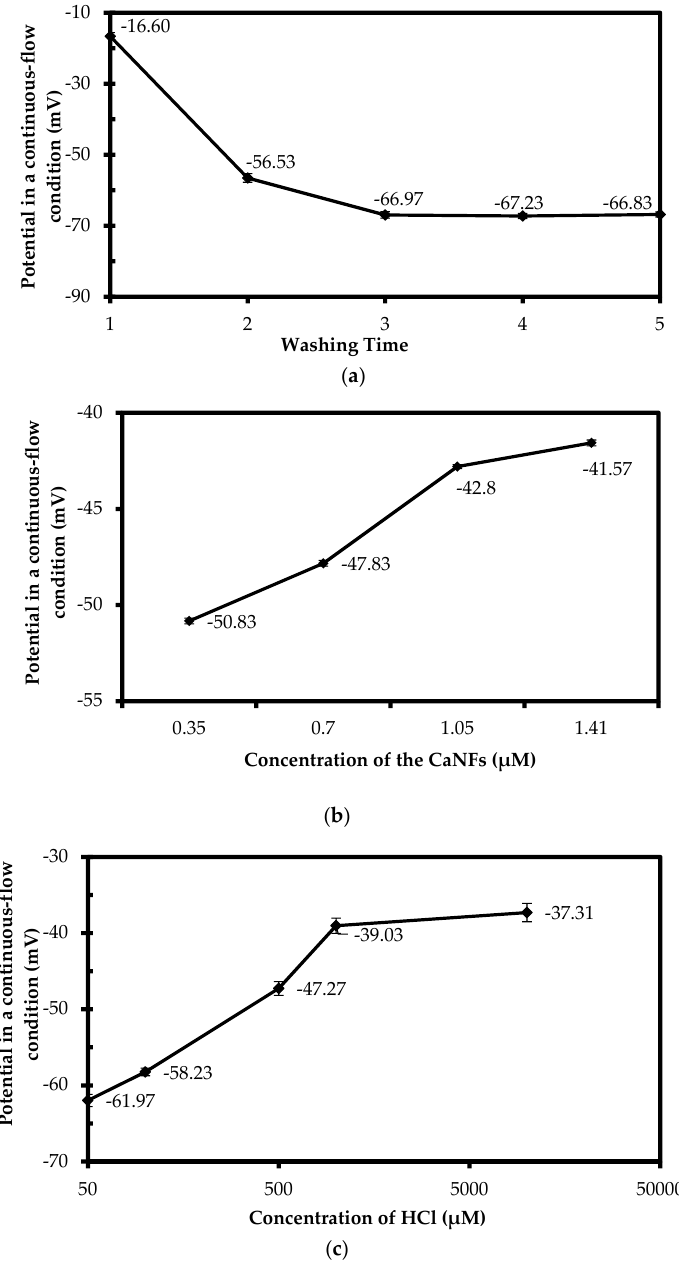
Figure 3. ( a ) Optimization of the washing time of the CaNFs ( N = 3); ( b ) Optimization of the concentration of the CaNFs ( N = 3); ( c ) Optimization of the concentration of hydrogen chloride ( N = 3).